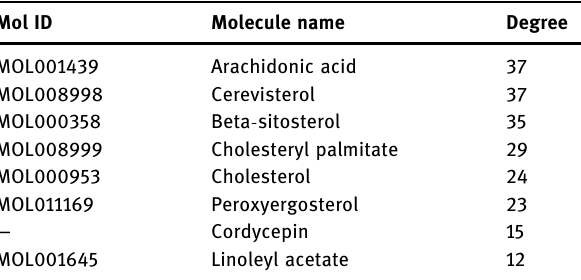
Table 2: Degree value of 8 main active components of C.